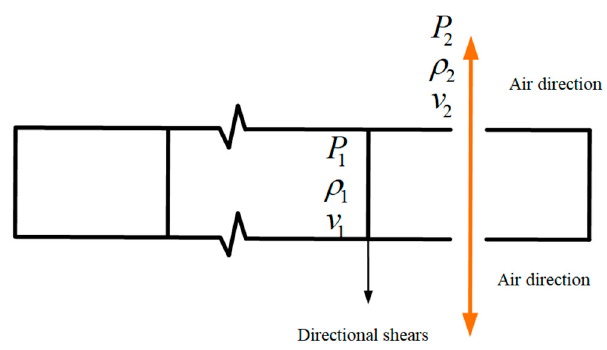
Figure 3. The schematic diagram of a high-pressure carbon dioxide jet.